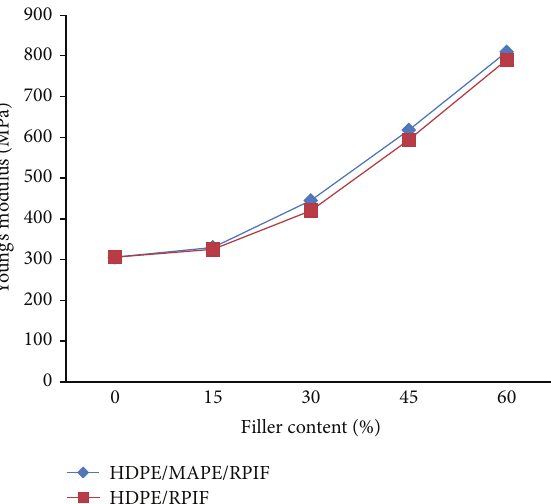
Figure 1: Effect of RPIF on tensile strength of RPIF/HDPE compos- ites.